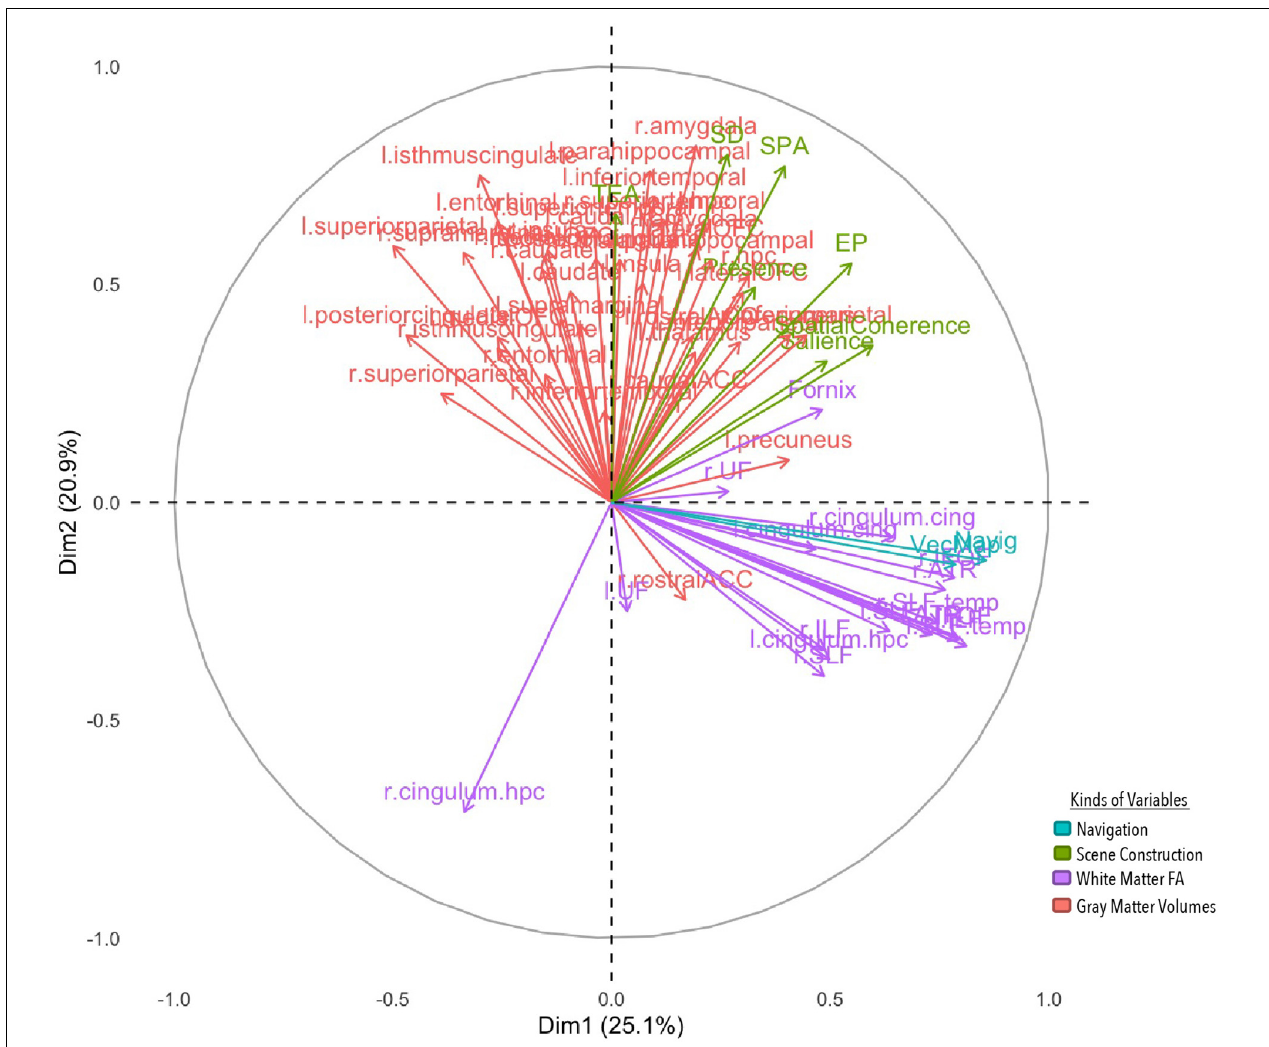
FIGURE 4 | MFA variable contributions. Variables are distinguished by color for whether they are a gray matter volume, measure of white matter FA, or aspect of performance on the navigation or scene construction tasks. Variables that covary together positively point in the same direction on a specific axis, and variables that covary together negatively point in opposite